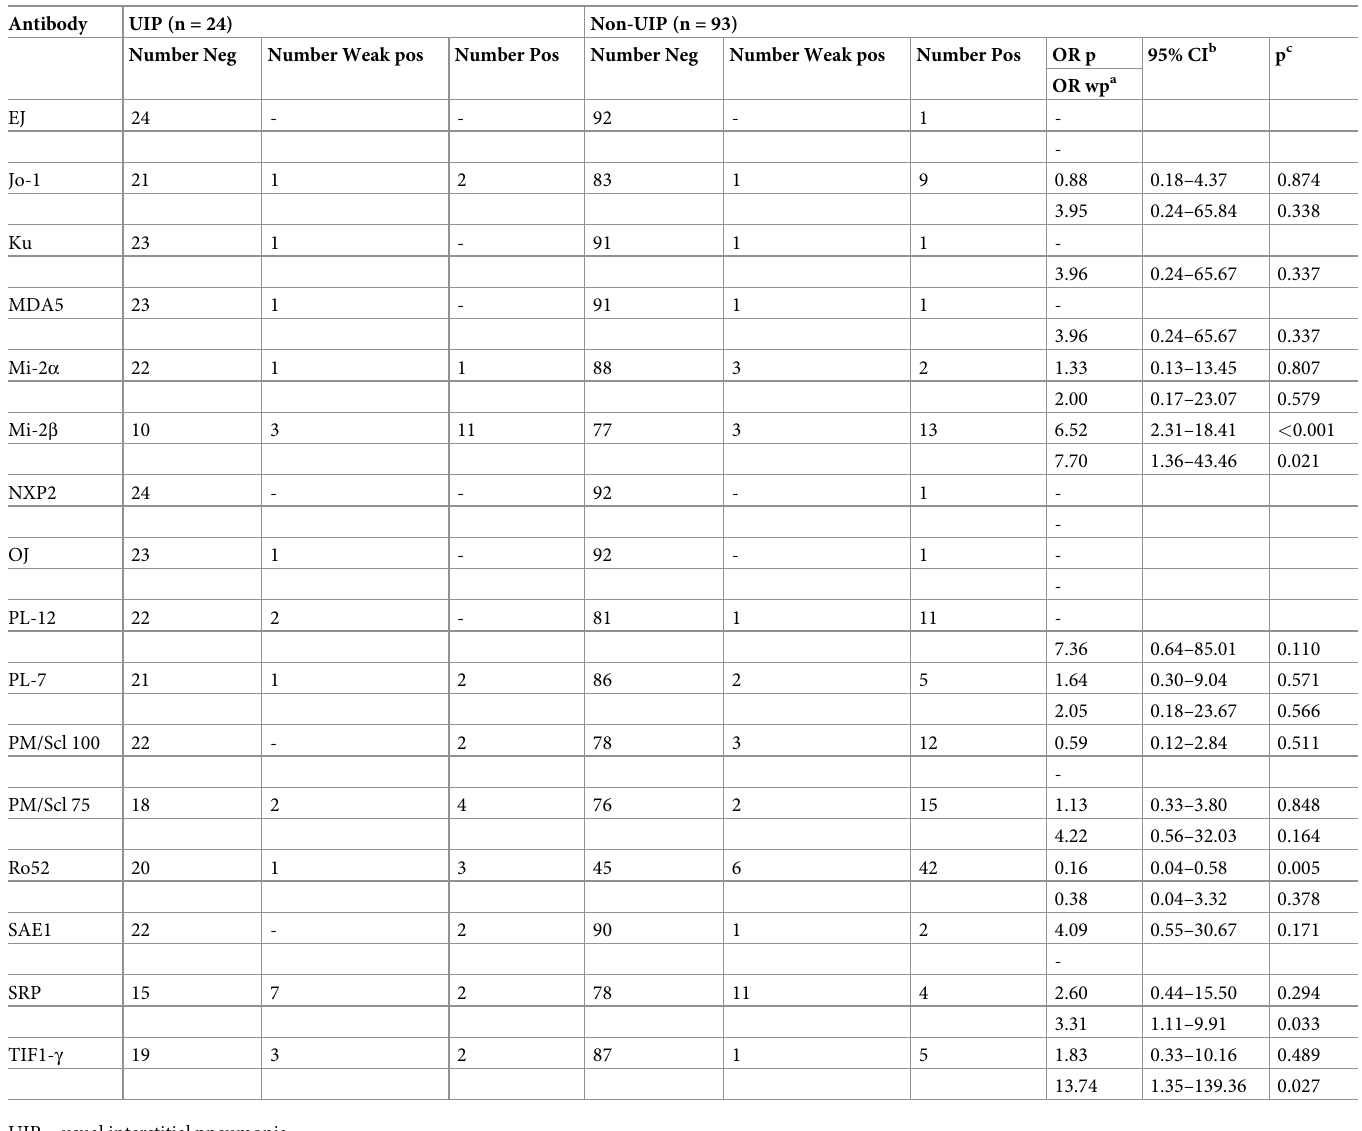
Table 4. Associations of myositis antibodies with a histological UIP pattern and non-UIP pattern.